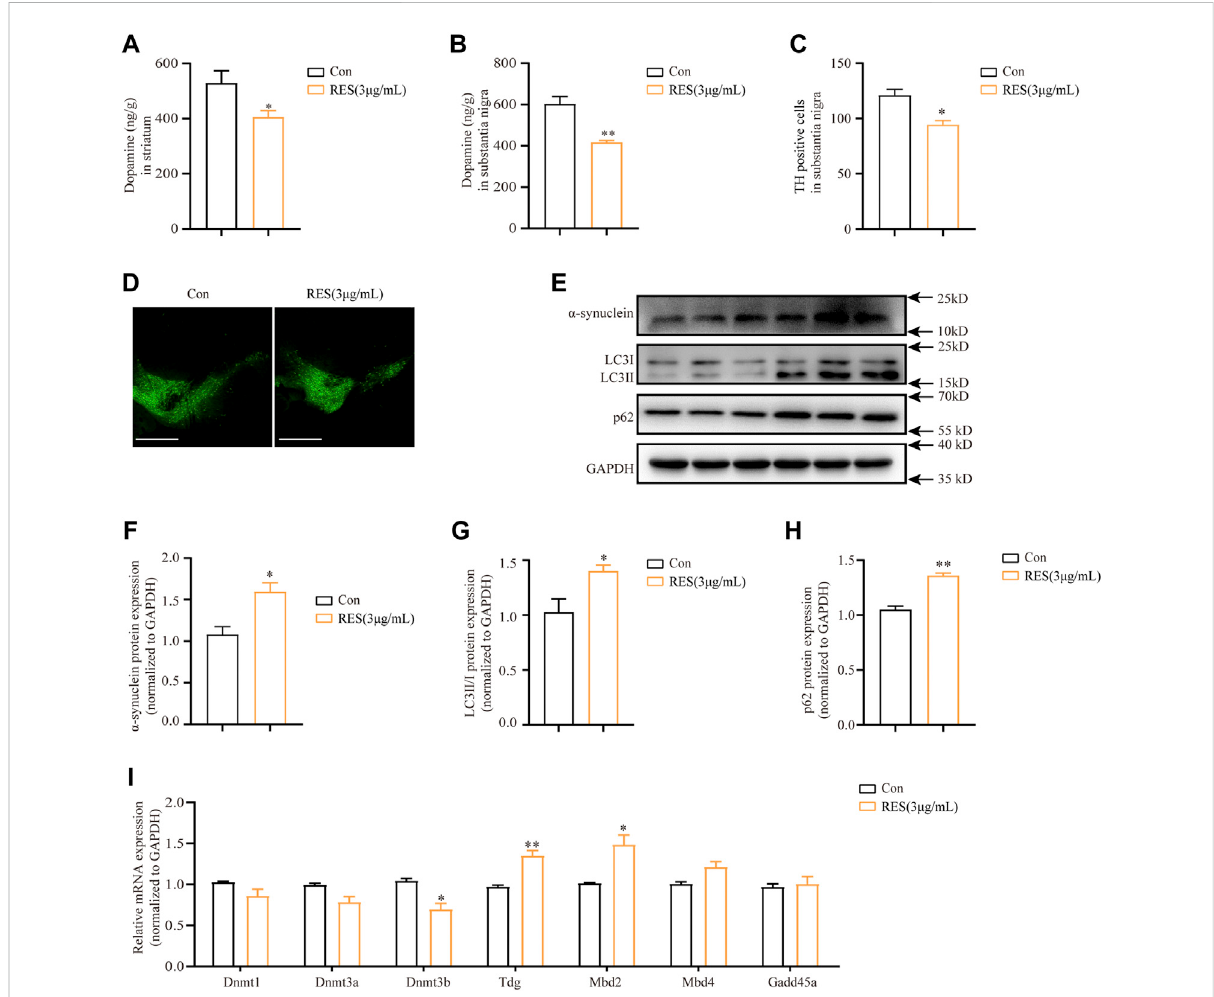
FIGURE 8 Reserpine induced autophagic dysfunction and lowers DNA methylation levels in mice. (A) The protein levels of dopamine were assayed by HPLC in the striatum ( n = 3 for each group, student t-test, * p < 0.05 vs. control). (B) The protein levels of dopamine were assayed by HPLC in the substantianigra ( n = 3 for each group, student t-test, ** p < 0.01 vs. control). (C,D) TH fl uorescence intensity decreased in substantia nigra; scale bar: 100 μ m ( n = 3 for each group, student t-test, * p < 0.05 vs. control). (E) Representative blots of SNCA, LC3, and p62 protein expression in the substantia nigra. (F – H) Are statistical plots ( n = 3 for each group, student t-test, * p < 0.05 ** p < 0.01 vs. control). (I) Changes in mRNA expression of methylation-related enzymes in the substantia nigra following reserpine treatment ( n = 5 for each group, student t-test, * p < 0.05 ** p < 0.01 vs. control). All data are presented as mean ± SEM; Con, control; RES,